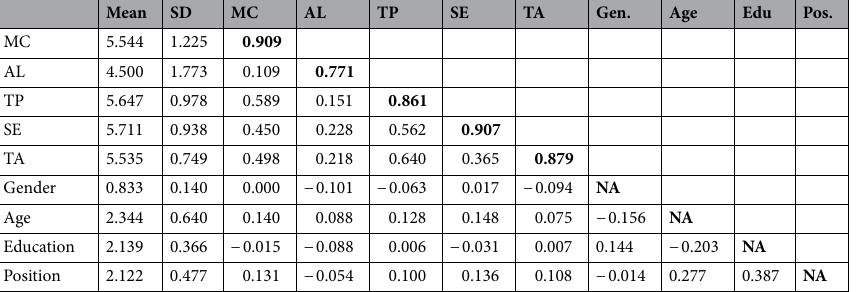
Table 7. Means, standard deviation and correlation. NA: not applicable. The square root of AVE is the bold numbers in the diagonal row.